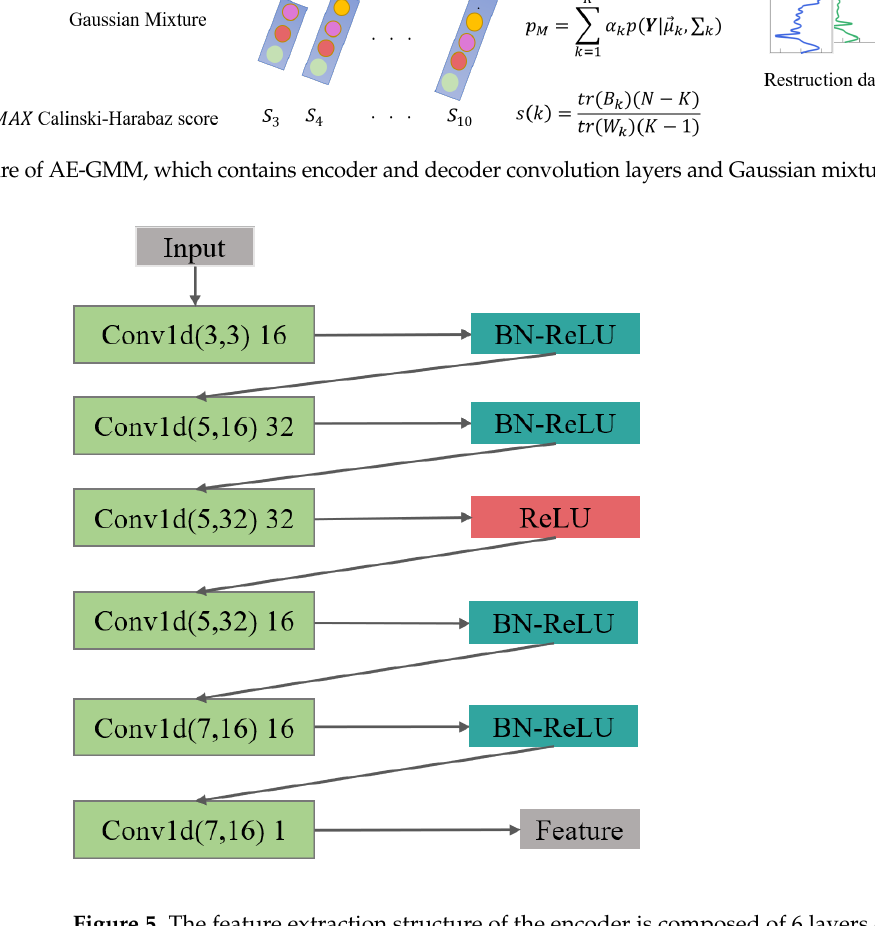
Figure 5. The feature extraction structure of the encoder is composed of 6 layers of 1D CNN, batch normalization (BN), and ReLU activation